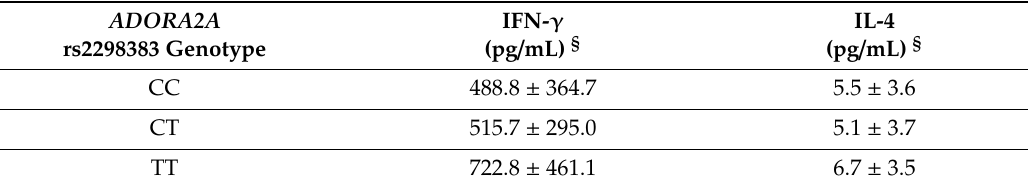
Table 3. Serum concentrations of secreted inflammatory cytokines in MCS patients having di ff erent ADORA2A rs2298383